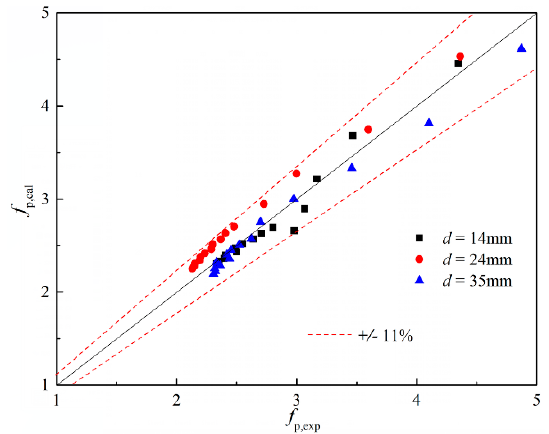
Figure 7. Comparison between the experimental values and the calculation values based on Equations (16) and (17).